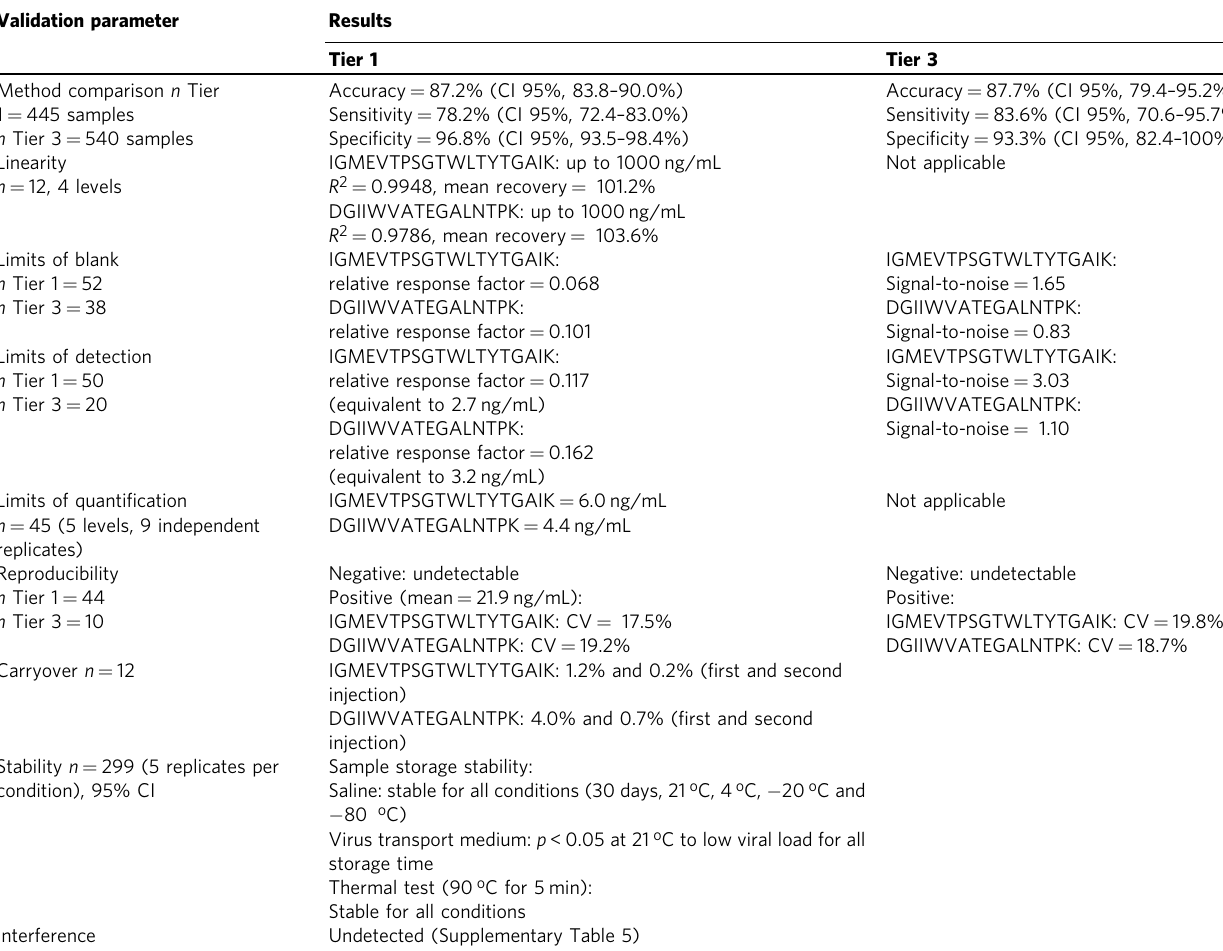
Table 3 Summary of validation parameters for Tier 1 and Tier 3 assays. CI: con fi dence interval. CV: coef fi cient of variation. Source data are provided as a Source Data fi